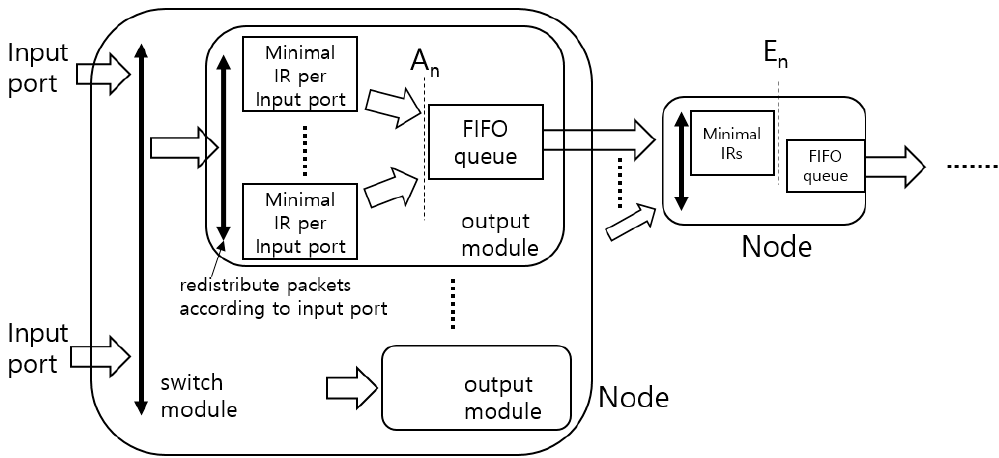
Figure 2. Implementation practice of the delay guarantee framework in asynchronous traffic shaping (ATS) [2].